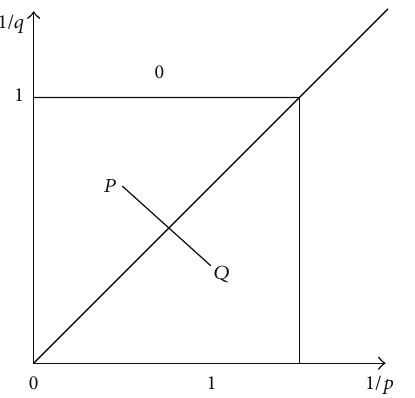
Figure 2: Contradiction argument using